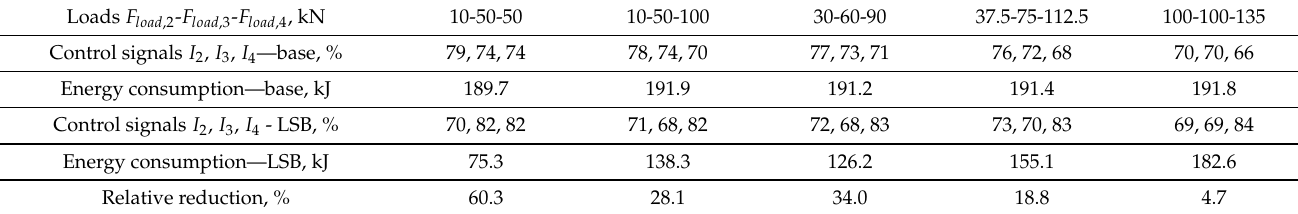
Table 5. Energy consumption, different loads, equal speeds of all